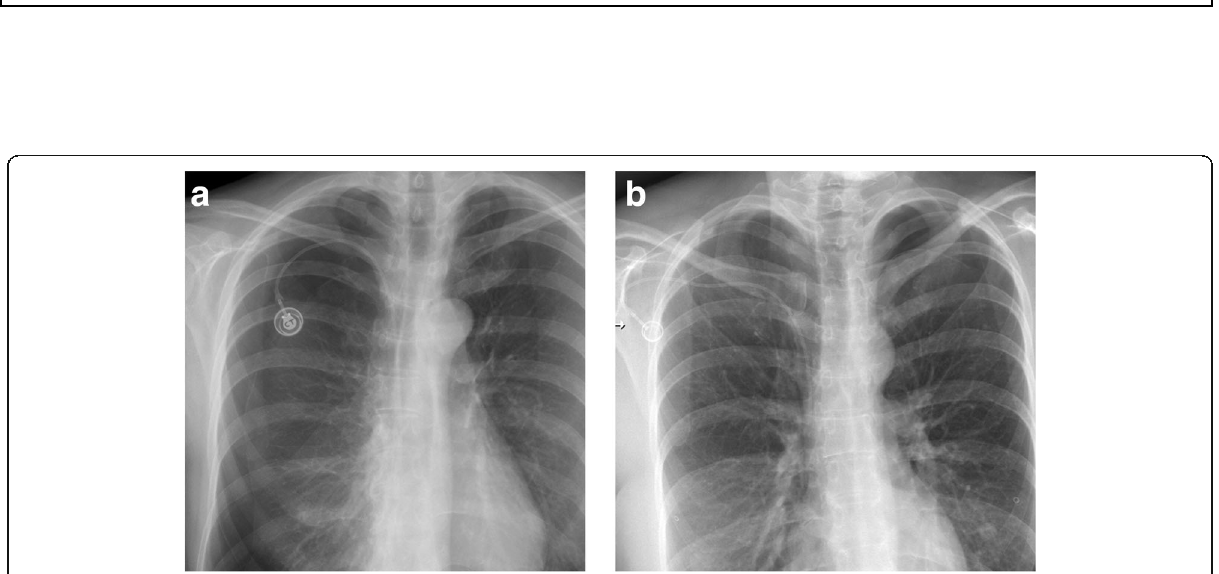
Fig. 6 Extravascular malpositioning. a Intraoperative fluoroscopy shows the catheter projecting above the clavicles, which is not in line with an intravascular position (in the brachiocephalic vein). b Port system was subsequently used for several weeks. Follow-up chest radiograph shows increasing pleural effusions. Malposition of the catheter was reported. c , d Subsequently a flow confirmation study was performed, which shows extravascular collection of contrast (star) and some contrast material reflux into the internal jugular vein (large arrow), the subclavian vein (small arrow), as well as along the catheter into cervical veins (arrowhead). The catheter has an extravascular course and perforated the contralateral venous angle, with chemotherapy infusions partly entering the venous systems, partly filling up the pleural